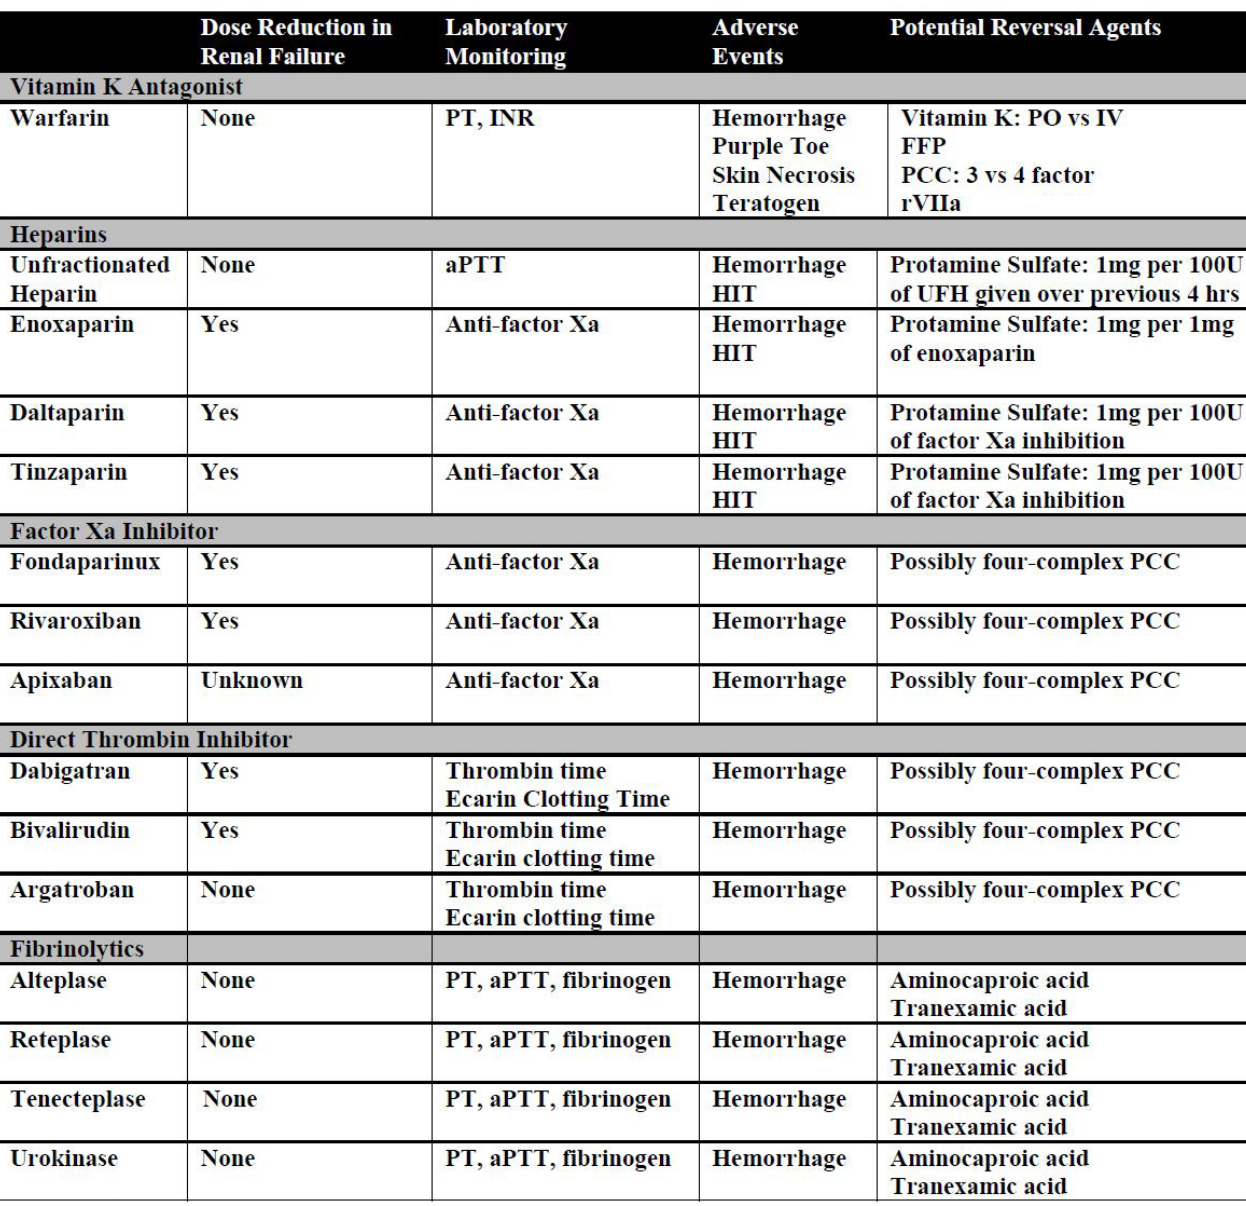
Figure 3 . Comparison table for anticoagulants. 9,19,25,38 PT , pro-thrombin time; INR , international normalized ratio; HIT, heparin-induced thrombocytopenia; PO , oral administration; IV , intravenous; FFP, fresh frozen plasma; aPTT, activated partial thromboplastin time; UFH , unfractionated heparin; PCC , prothrombin complex